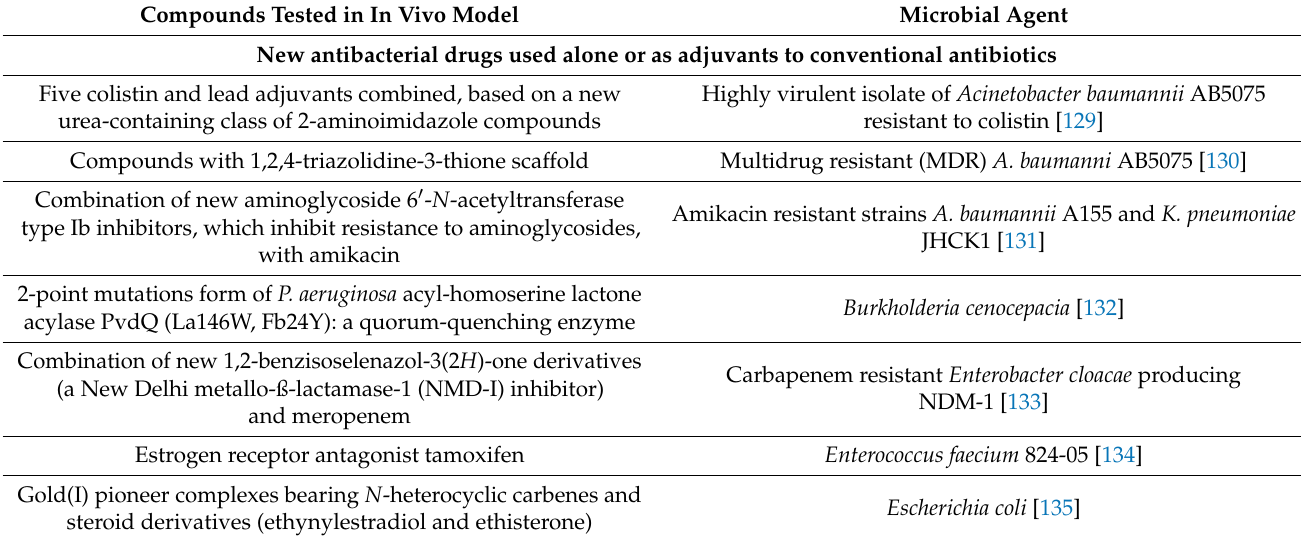
Table 3. Screening of antibacterial drugs using G. mellonella infection models. Compounds Tested in In Vivo Model Microbial